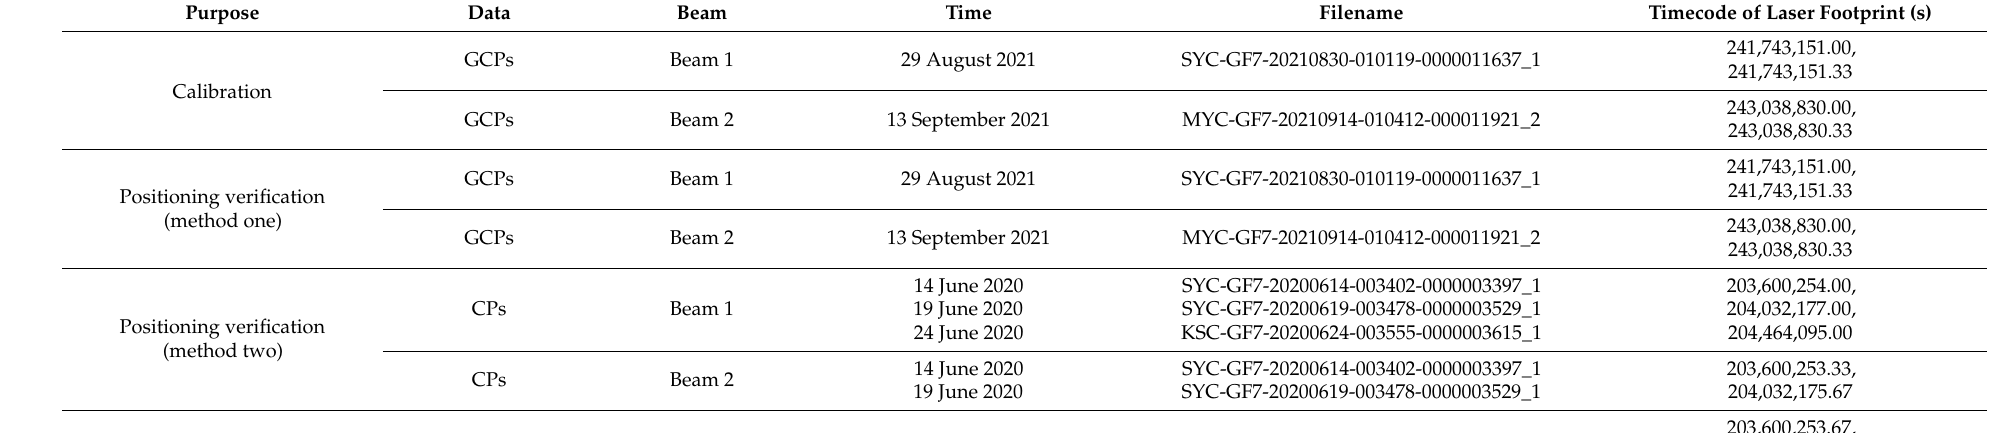
Table 1. Experimental and validation data used in this